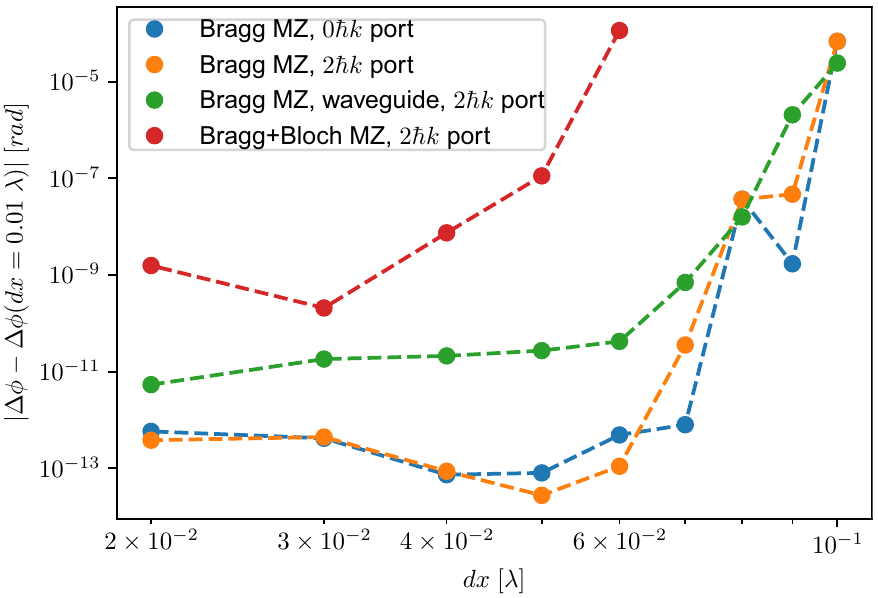
Figure 8. Numerical convergence analysis of three different interferometer realisations given by a 2 (cid:31) k Mach– Zehnder interferometer (blue and orange dots corresponding to the 0 (cid:31) k and 2 (cid:31) k ports), a 2 (cid:31) k Mach–Zehnder 2 ) (cid:31) k Bragg+Bloch Mach–Zehnder interferometer (red interferometer in a waveguide (green dots) and a ( 2 + dots). We analyse the numerical convergence behaviour when changing the position step dx expressed in 780 nm of the numerical simulation using the third-order split-operator method with temporal units of (cid:31) = 1 µ s and dt free 10 µ s . The Gaussian splitter and mirror pulses have peak Rabi frequencies steps of dt int = = 50 µ s, respectively. The Bloch sequence is 1.0573 ω 25 µ s and τ of (cid:31) r with pulse lengths of τ bs = m = = 0.5 ms during 0.5 ms, a frequency chirp time of τ implemented with an adiabatic loading time of τ load chirp = = 0.5 ms. The Rabi frequency which the momentum transfer occurs and an adiabatic unloading time of τ unload = of the Bloch lattice is